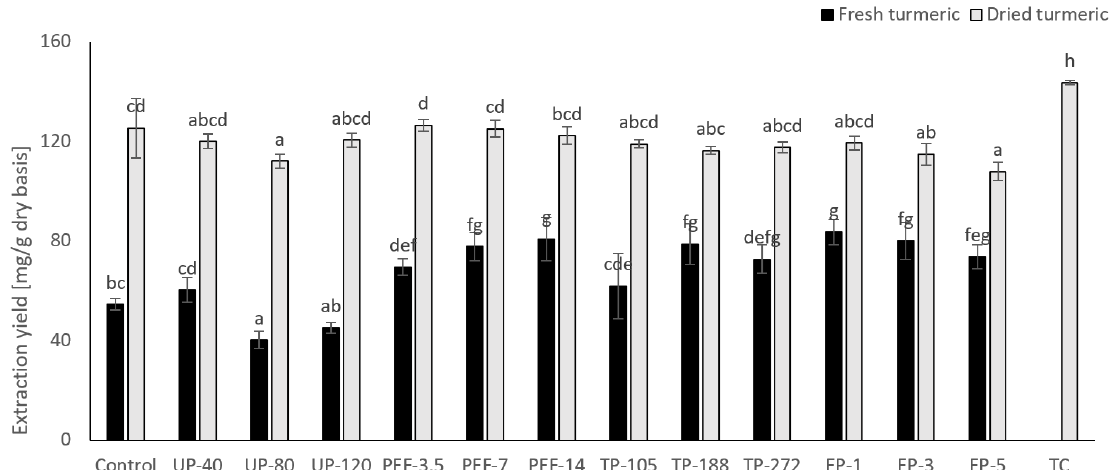
Figure 2. Effect of pretreatment on total curcuminoid recovery. Means with a different letter are significantly different ( p < 0.05).